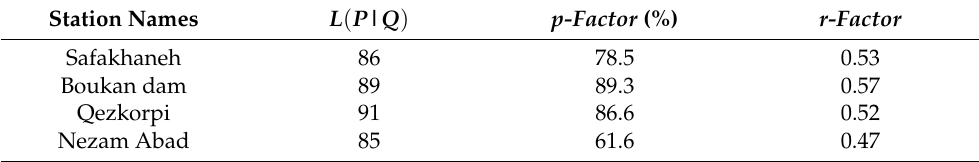
Figure 7. Uncertainty interval (95 PPU) of input data for ( a ) Safakhaneh, ( b ) Boukan dam, ( c ) Qezkorpi, ( d ) Nezamabad; the gray area is the uncertainty interval and the dots are observations. Table 3. Input uncertainty estimation of the GRU model for the Zarrineh River